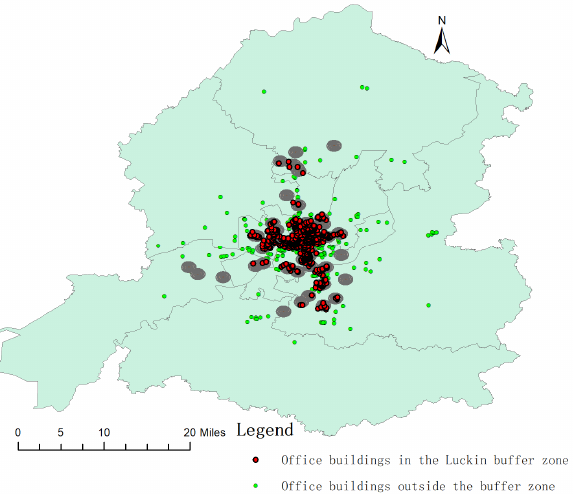
Figure 8. Coverage of Luckin Coffee in office buildings.